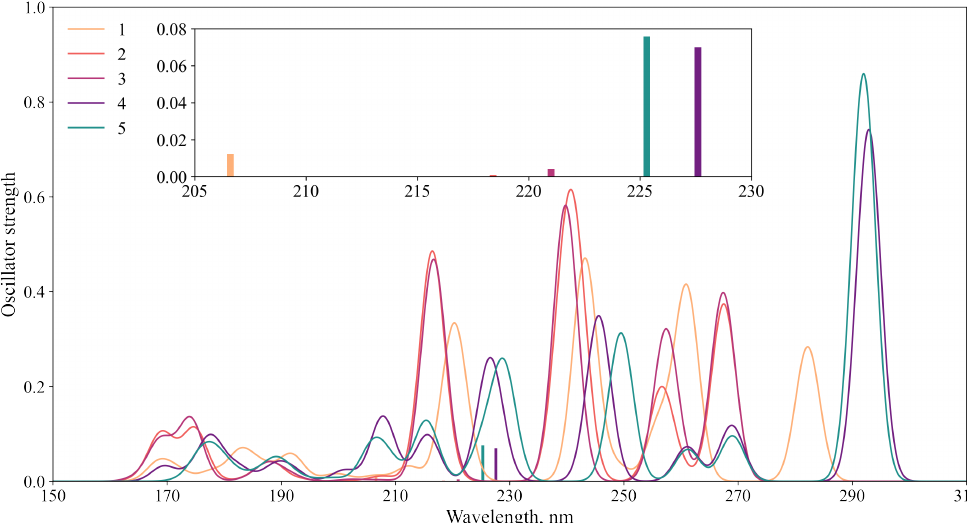
Figure 8. Excitation spectra of model structures, FWHM = 5 nm. Sticks represent excitations with CT contributions.